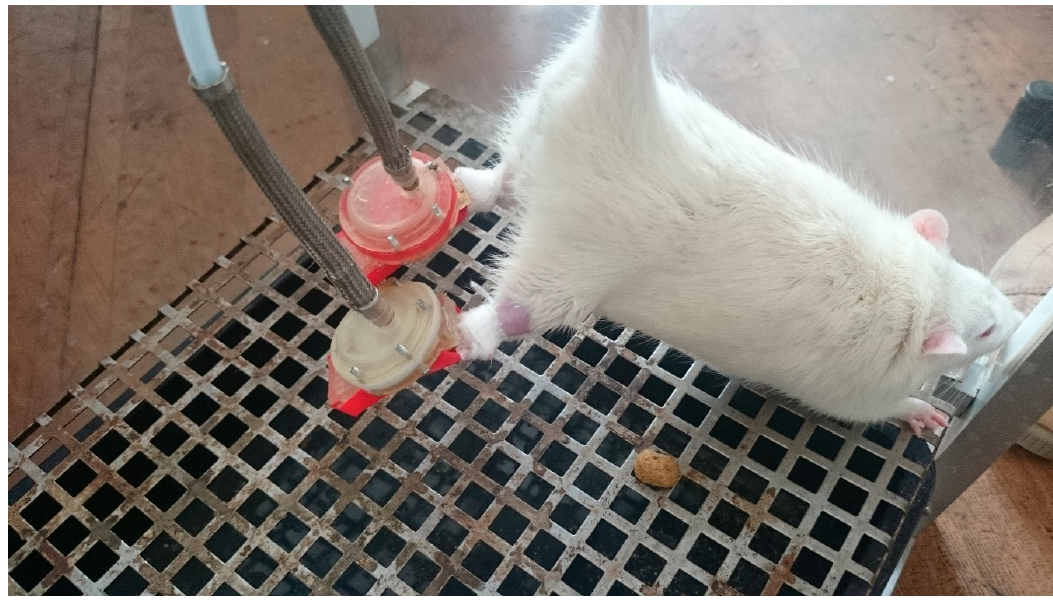
Figure 9. A photo of PMS application.